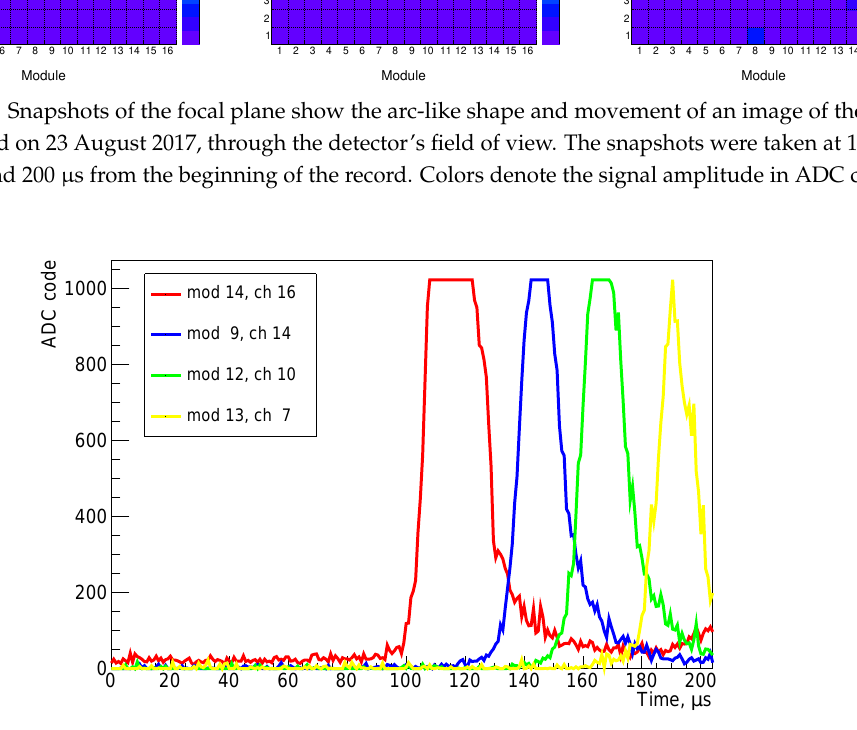
Figure 3. Waveforms of several hit pixels of the elve registered on 23 August 2017, above Pacific